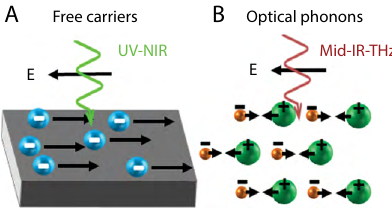
Figure 1 Schematic illustrating the collective oscillations of (A) free carriers in metals and (B) atomic displacements in the form of optical phonons in polar dielectrics that oppose incident radiation at frequencies below the plasma frequency of metals or between the longitudinal and transverse optical phonons in polar dielectrics. These oscillations are the foundations for the SPP and SPhP modes discussed in the